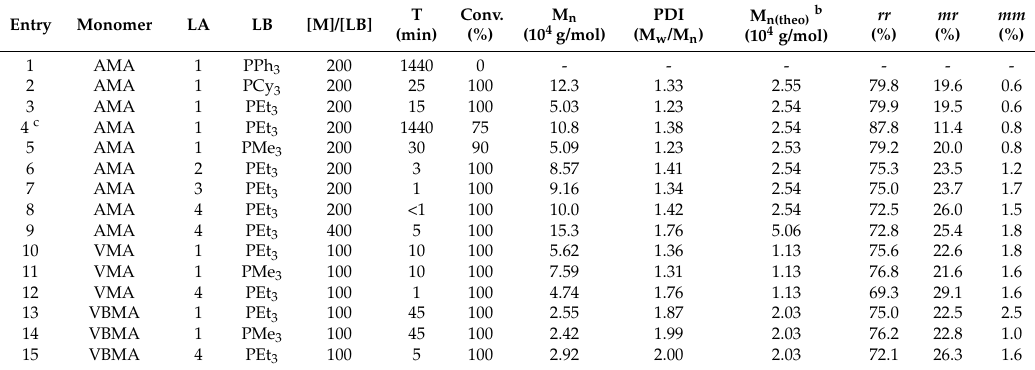
Table 1. Chemoselective polymerization of polar divinyl monomers with homoleptic rare-earth aryloxide-based Lewis pairs a